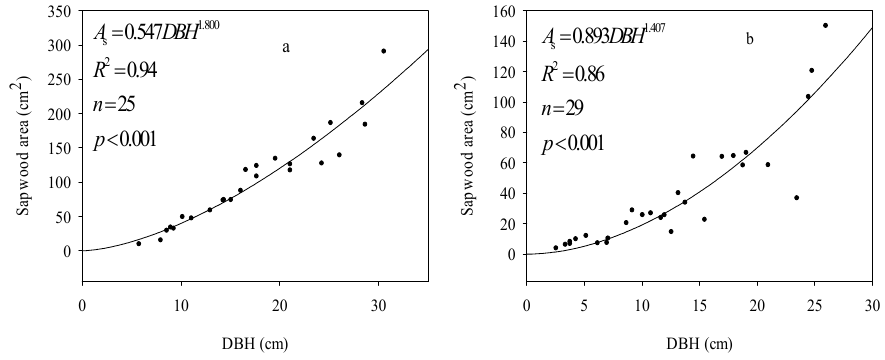
Figure 1. Regressions of sapwood area ( A s ) with the diameter at breast height (DBH) for oak ( a ) and apricot ( b ) trees.